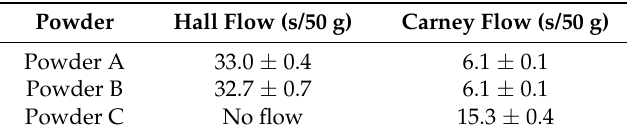
Table 2. Summarises the powder flowability of powders A, B, and C determined by Hall and Carney funnels.